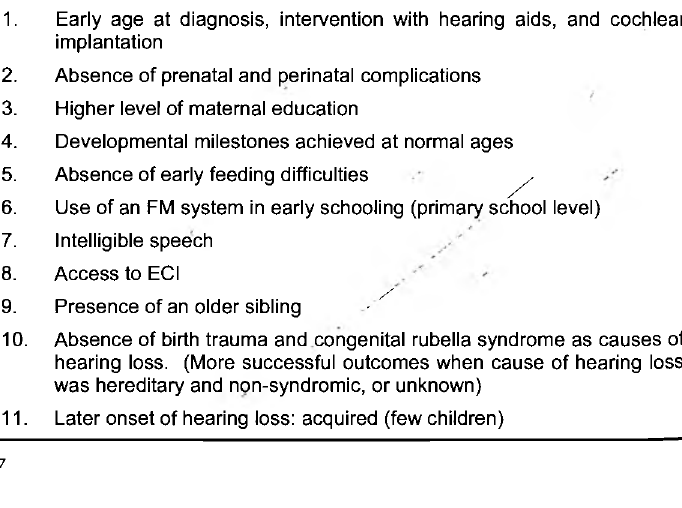
Table 5: Eleven most important variables associated with successful out­ comes of children with cochlear implants in the PCIP ,